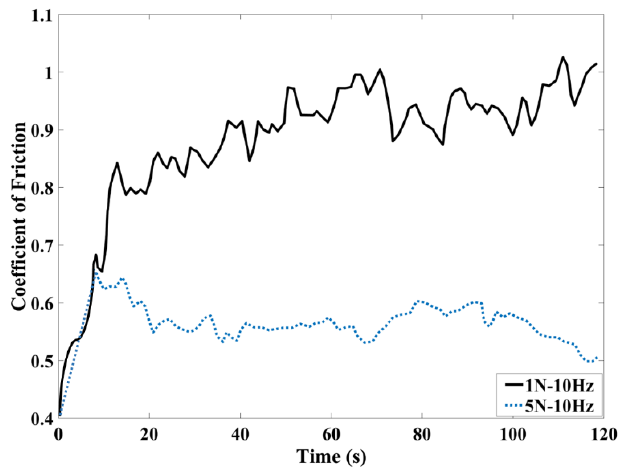
Figure 8. Effect of load on the coefficient of friction. Figure 8. E ff ect of load on the coe ffi cient of